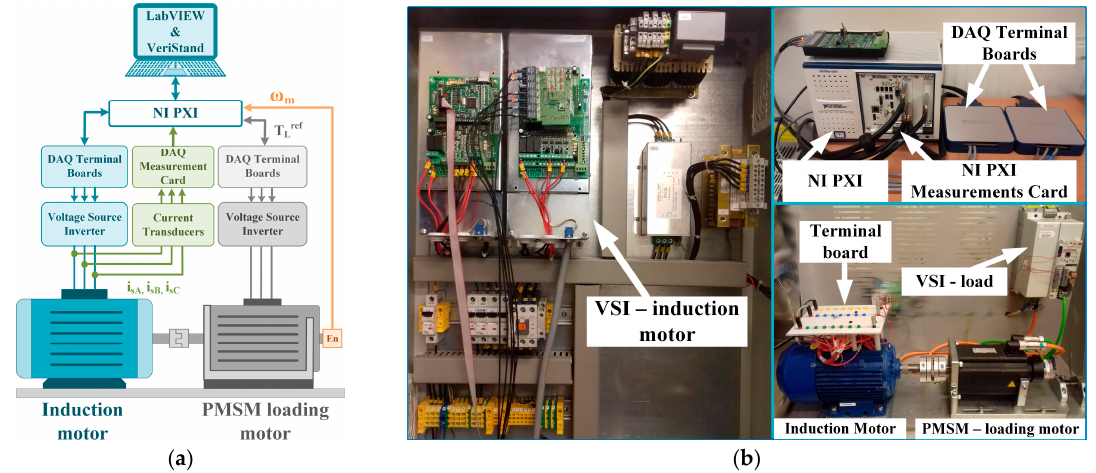
Figure 2. Experimental set-up: ( a ) general scheme of the set-up; ( b ) components of the real experimental drive system.